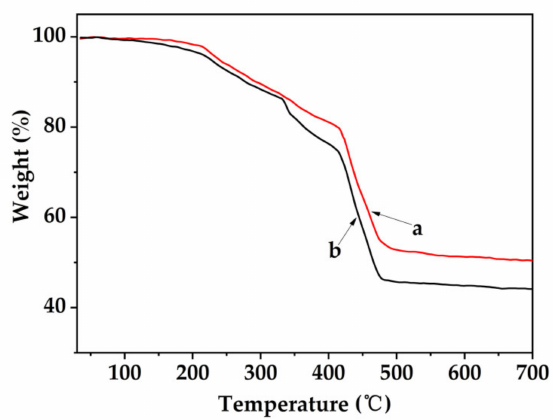
Figure 4. Thermal gravimetry analysis (TGA) curves of ( a ) SAP and ( b ) SAPC (4 wt. %